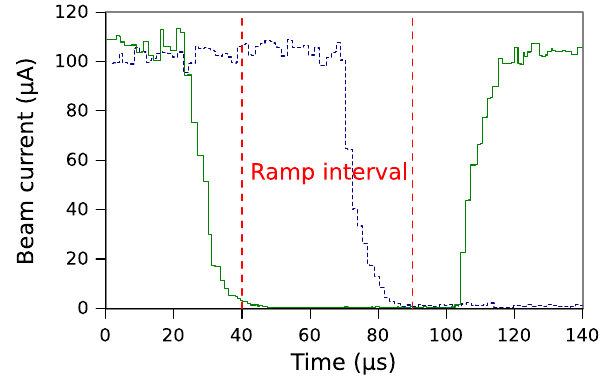
FIG. 19. Beam current in beamline 1V as measured with the 1VM4.7 capacitive probe. If the notch is correctly aligned (green solid line) with the time when the kicker magnet is ramping (vertical red lines) no beam is spilled on the septum magnet. A misaligned notch (blue dashed line) will cause significant beam